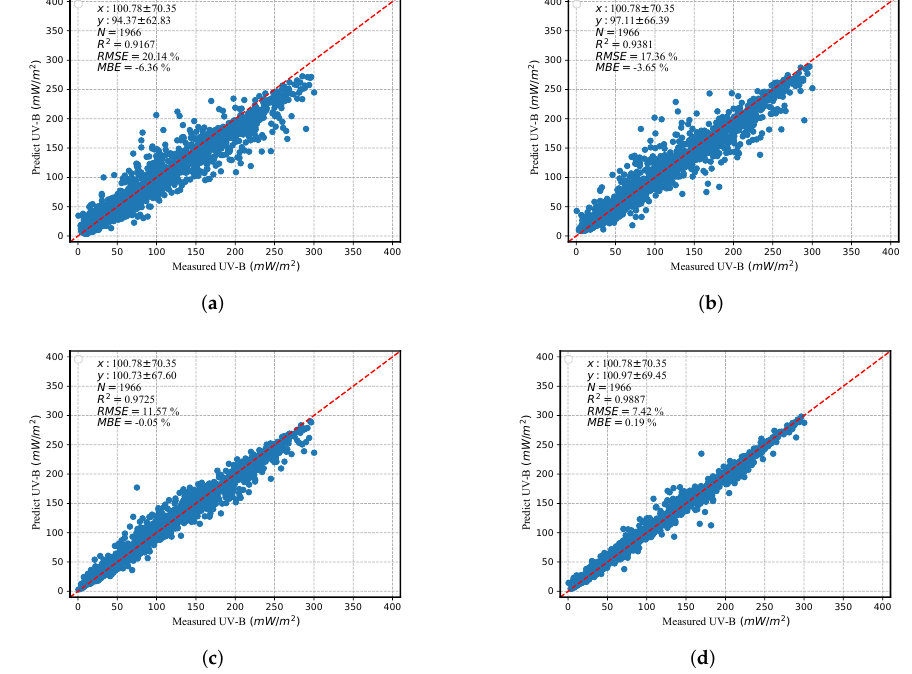
Figure 4. Comparison between measured erythemal UV-B and estimated UV-B on SURFRAD test data: ( a ) FCNN model; ( b ) DRFCN model; ( c ) FCNN+RF model; ( d ) DRFCN+RF